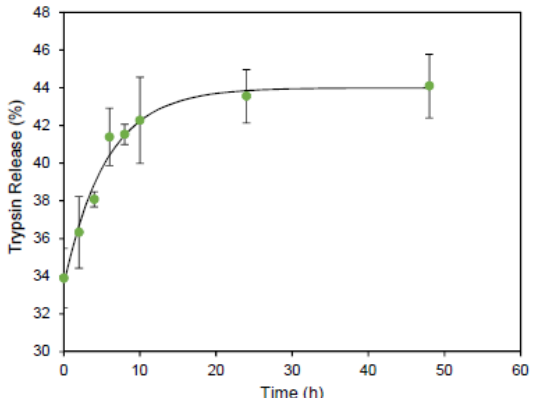
Figure 9. Release kinetics of trypsin from chitosan particles produced by SMART platform. Data points represent mean ± SD ( n = 3).